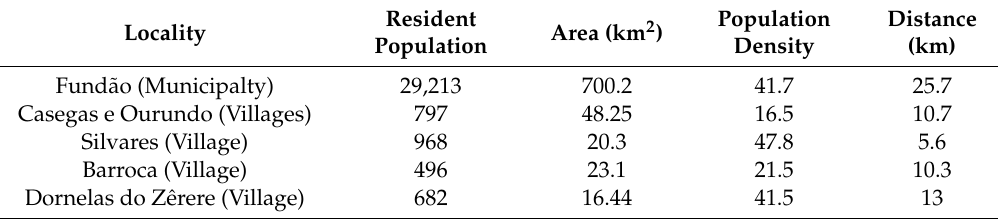
Table 1. Population distribution in the Cabeço Pi ã o 1 region. Locality